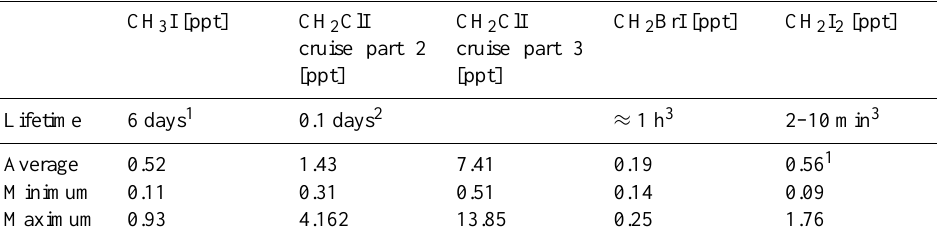
Table 2. Iodocarbons measured during the TransBrom cruise. Since CH 2 ClI mixing ratios varied during the cruise, average values for cruise part 2 and part 3 were